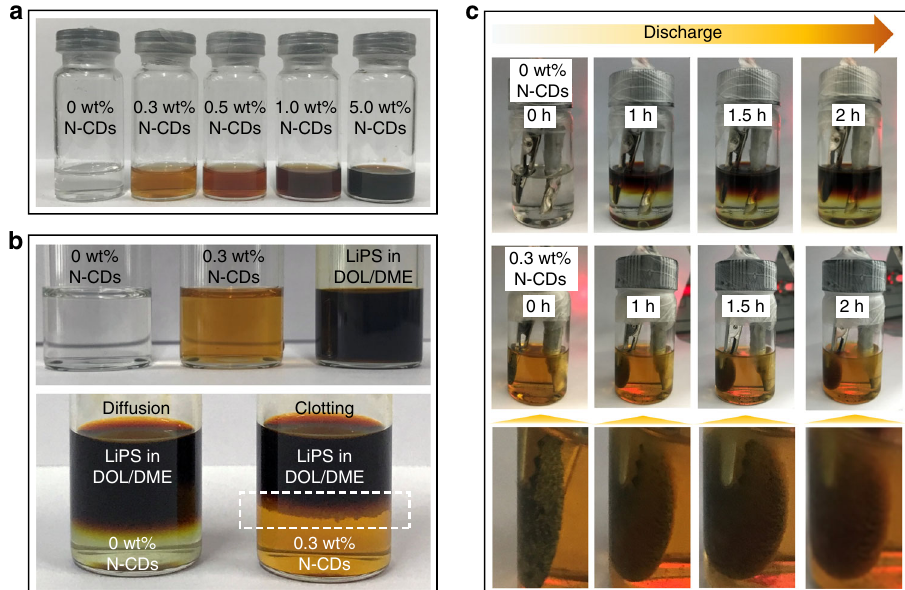
Fig. 2 Photographs showing the formation of chemical and electrochemical LiPS/N-CDs clotting layers. a Electrolyte with different N-CD contents (0, 0.3, 0.5, 1.0, and 5.0 wt%). b Interaction between LiPS and electrolyte containing 0 and 0.3 wt% N-CDs. The white dashed frame highlights the formation of the protective layer at the LiPS/electrolyte interface. c Visual changes in the cell system during discharge in electrolytes containing 0 and 0.3 wt% N- cell with 0 and 0.3 wt% N-CDs electrolyte during discharge. For discharge is nearly the same as that at the beginning. More the cell without N-CDs, the color of the electrolyte appears importantly, the sulfur cathode is covered with a thin LiPS/N- reddish brown after 2 h of discharge, owing to the high CDs clotting layer after 1 h of discharge that becomes thicker as concentration of long-chain LiPS. However, for the cell with the discharge time increases, further con fi rming that N-CDs 0.3 wt% N-CDs electrolyte, the color of the electrolyte after 2 h of possess a signi fi cant clotting function for LiPS and that the